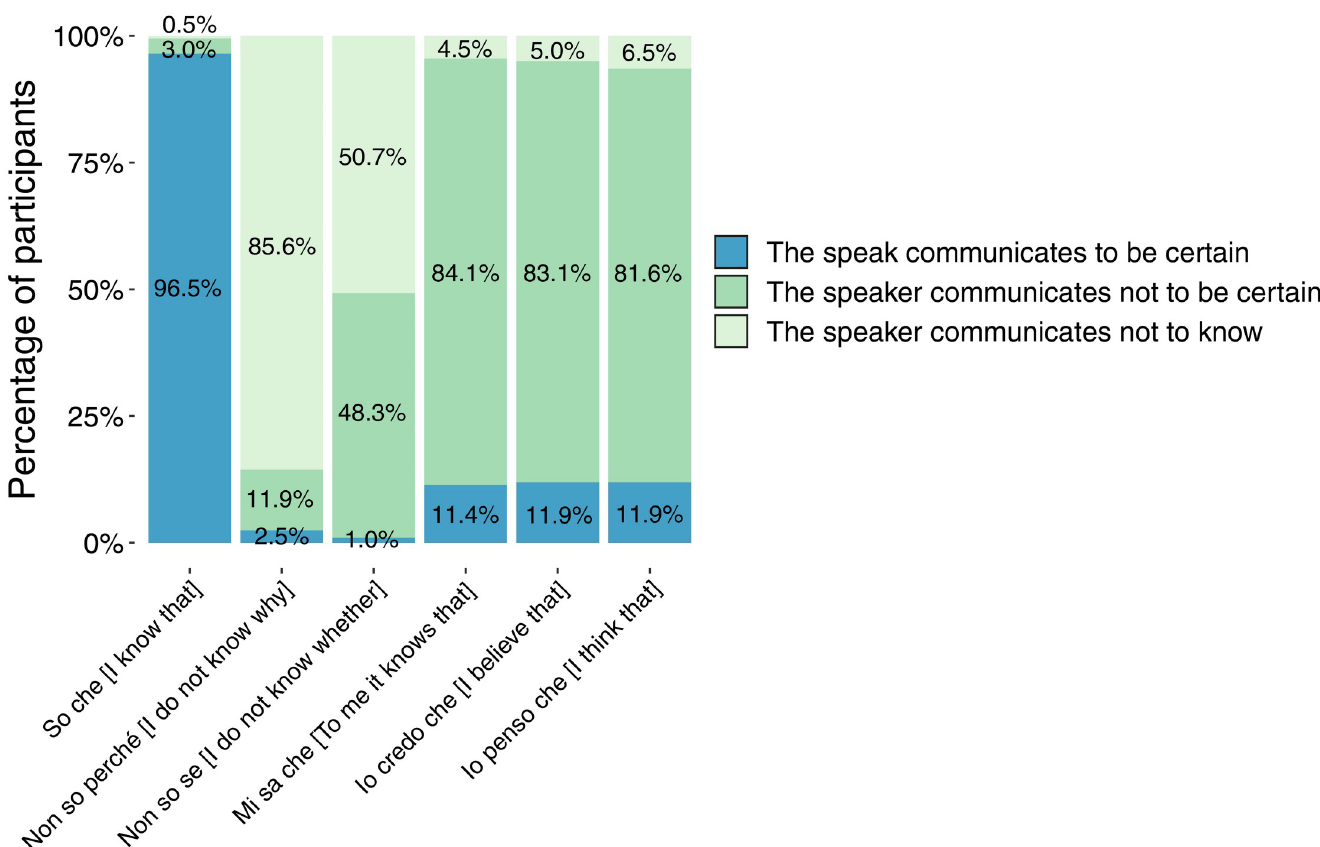
Fig 3. Percentages, rounded to the first decimal, of participants who chose which EMPs for which sentences.